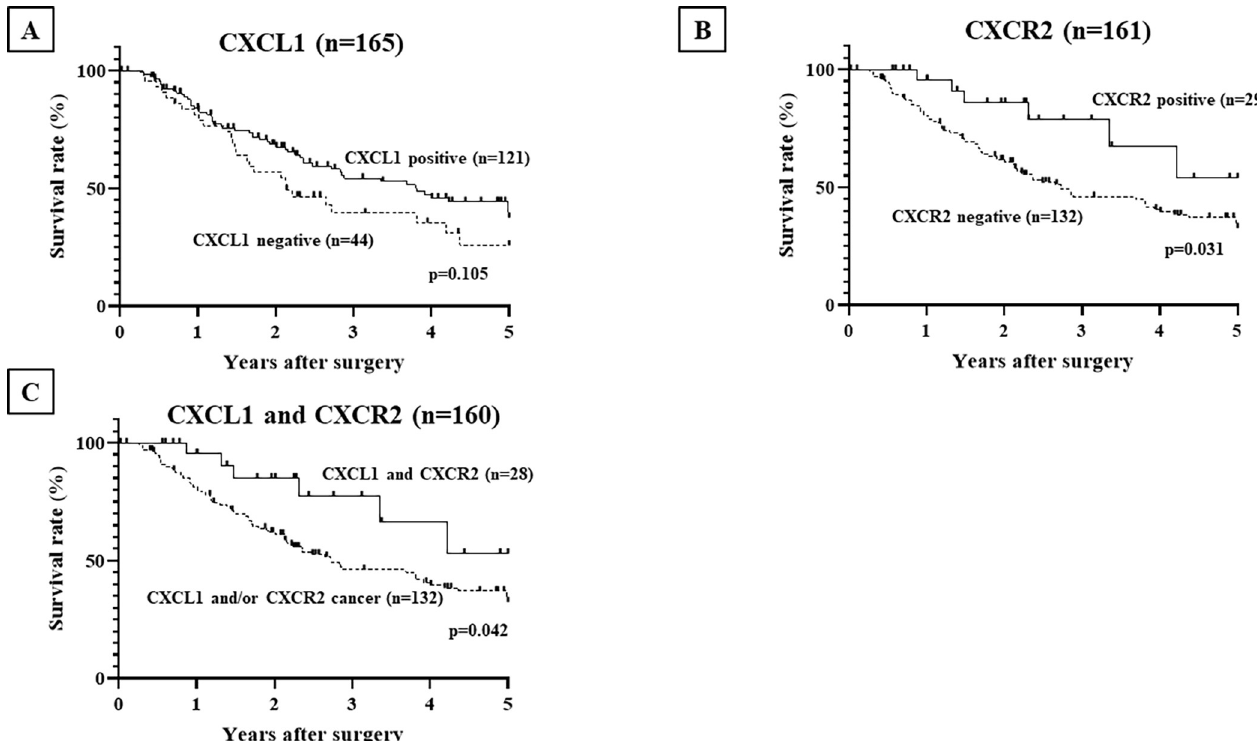
Fig 3. The overall survival rate of CCA patients according to CXCR2 expression. The patients with a positive expression of CXCR2 (n = 29) had a significantly better survival rate than those without CXCR2 expression (n = 132). The patients with positive expressions of both CXCL1 and CXCR2 (n = 28) had a significantly better survival rate than those with no CXCR2 expression (n = 132), but the patients with positive CXCL1 expression (n = 121) did not have a significantly better survival rate than those without CXCL1 expression (n = 44).